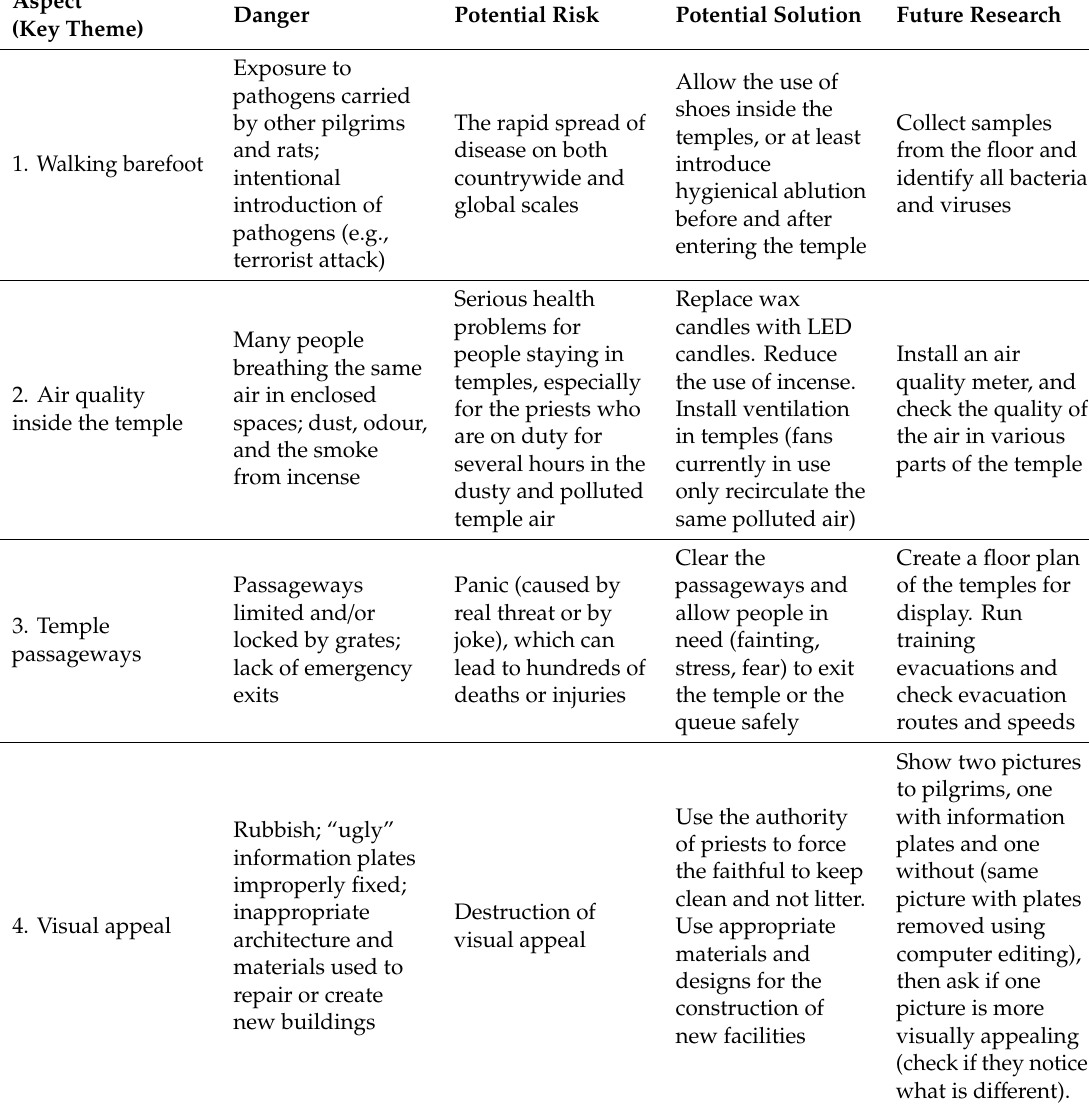
Table 2. Experience, visitation impacts, health hazards, and the future research potential of Indian Hindu